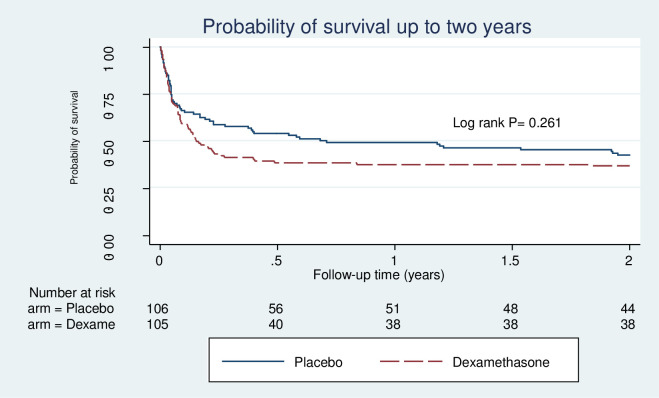
Kaplan-Meier plot showing survival of participants in the first 2 years of enrolment categorised per intervention.